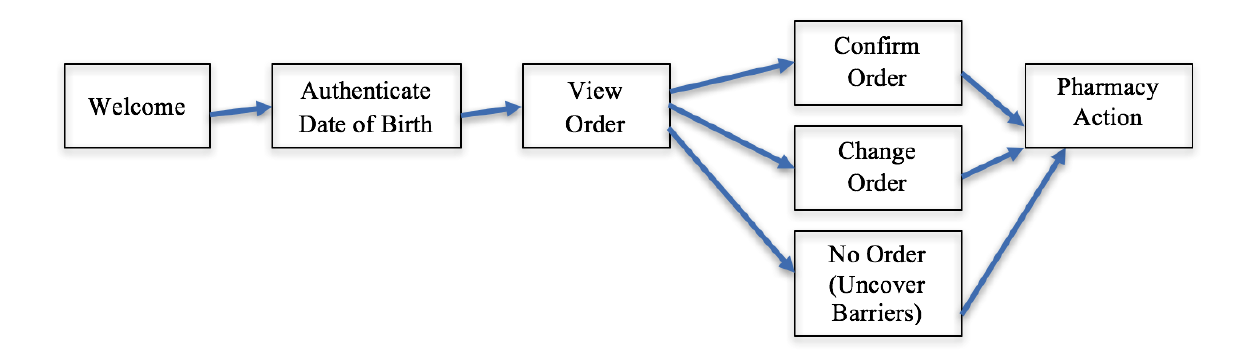
Figure 1. Overview of message flow within refill